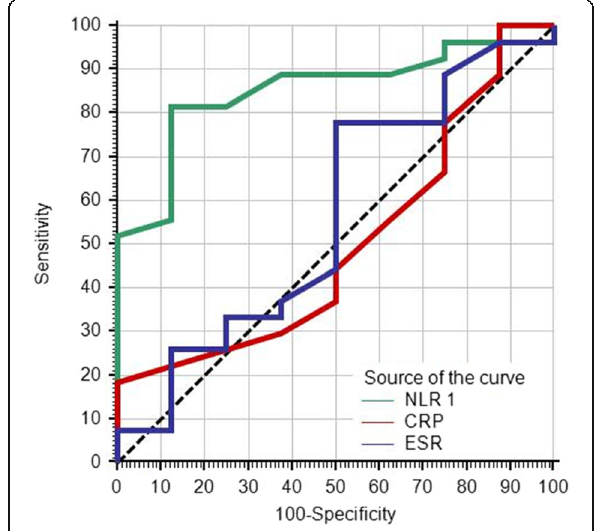
Fig. 1 ROC curve analysis of NLR, ESR, and CRP in the prediction of response to plasmapheresis. NLR neutrophil – lymphocyte ratio, ESR erythrocyte sedimentation rate, CRP C-reactive